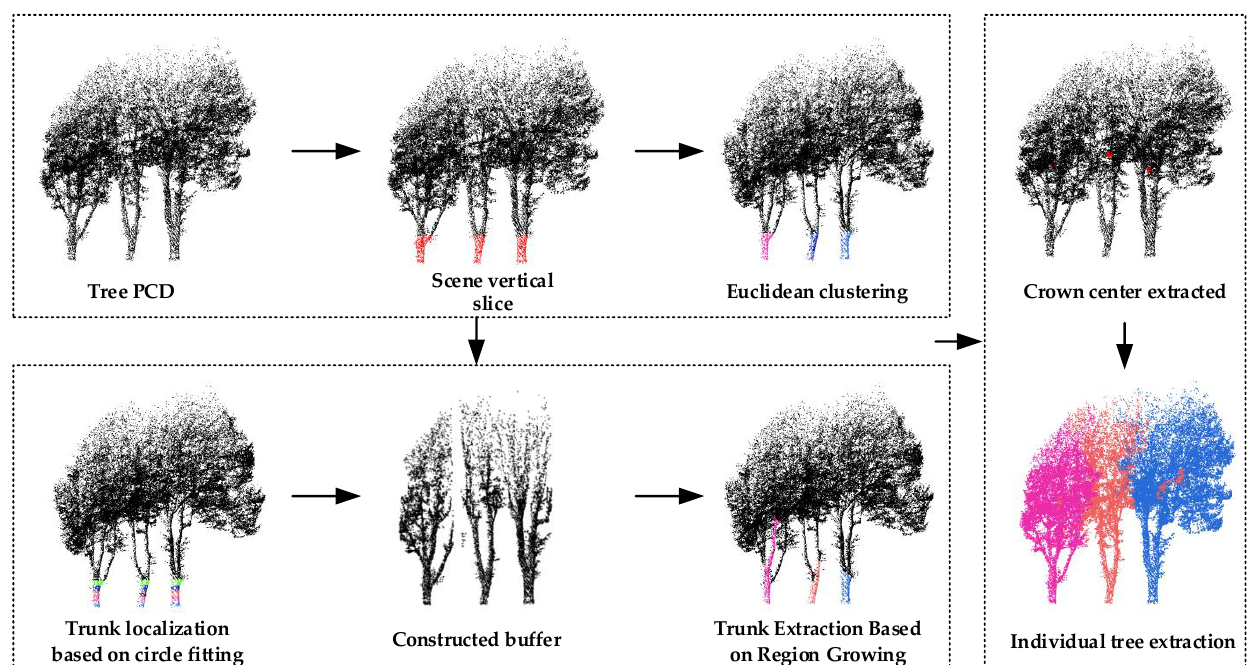
Figure 1. Pipeline of the proposed framework.